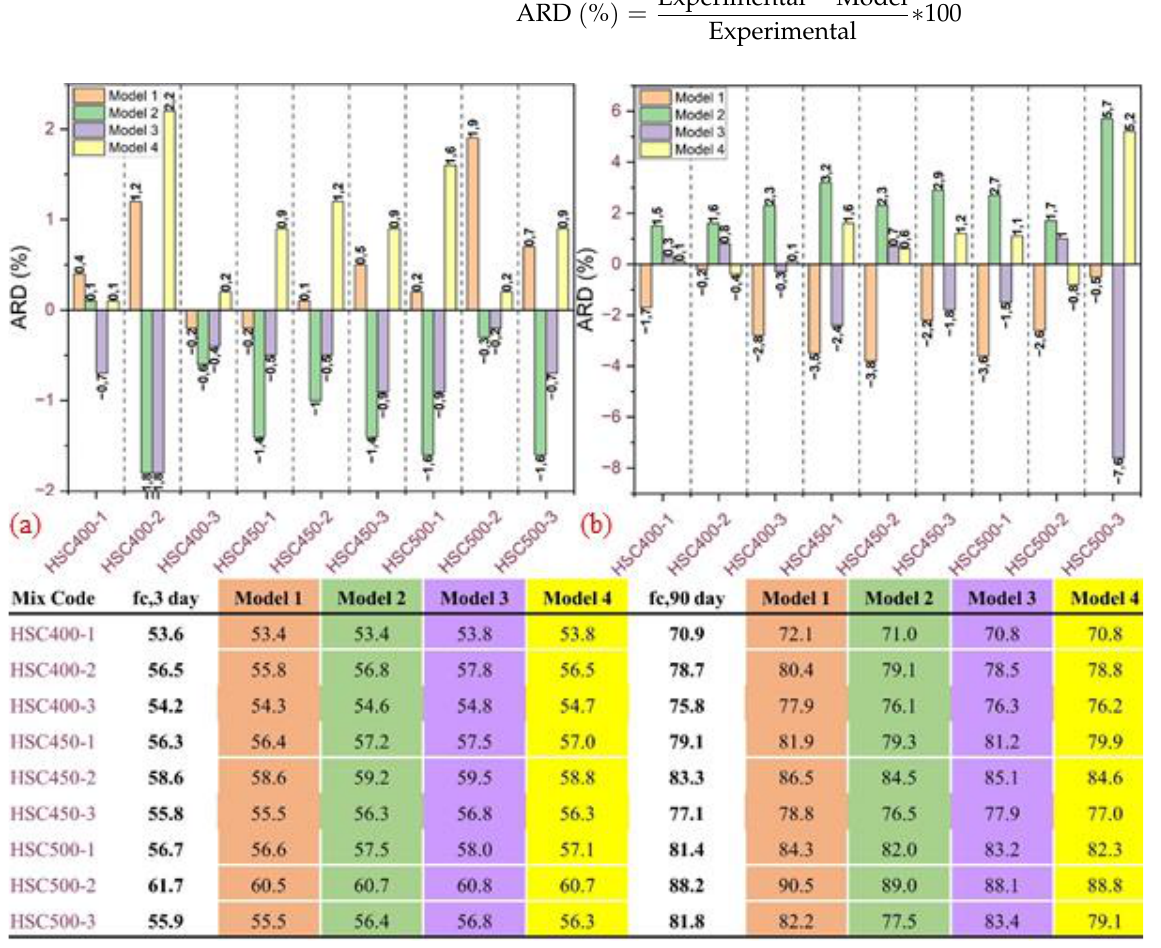
Figure 9. Experimental and predicted results: ( a ) Early-age, ( b ) Final-age strength.